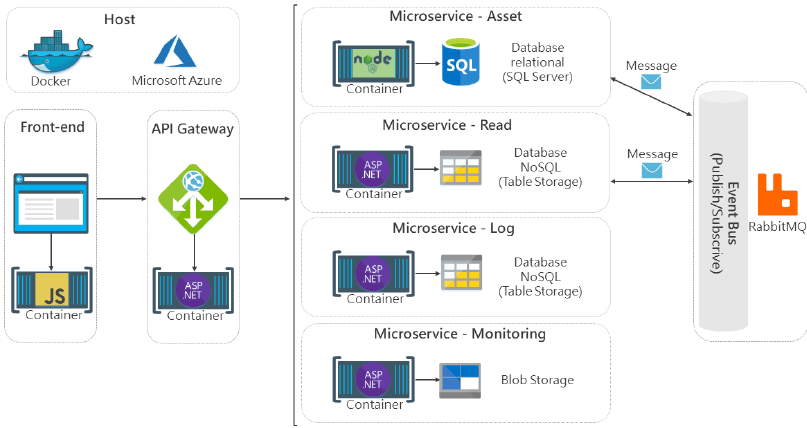
Figure 4. Architecture of Services